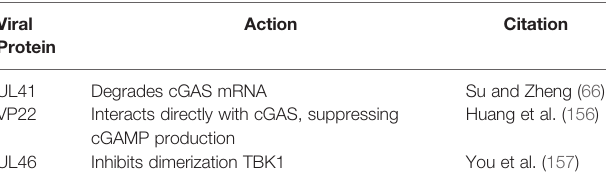
TABLE 3 | HSV – 1 Proteins and Innate Immune